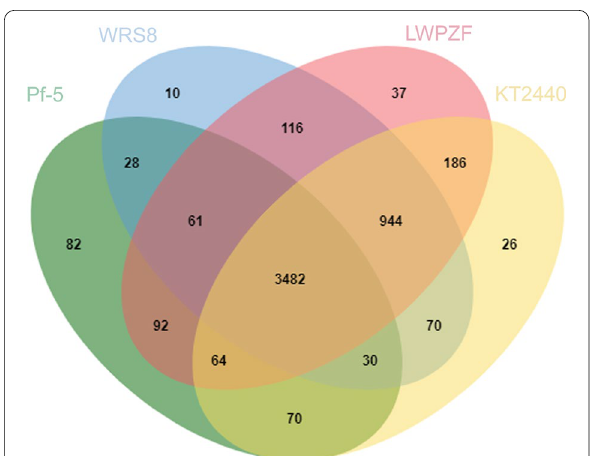
Fig. 5 Orthologous protein clusters shared by the genome of LWPZF, KT2440, WRS8 and